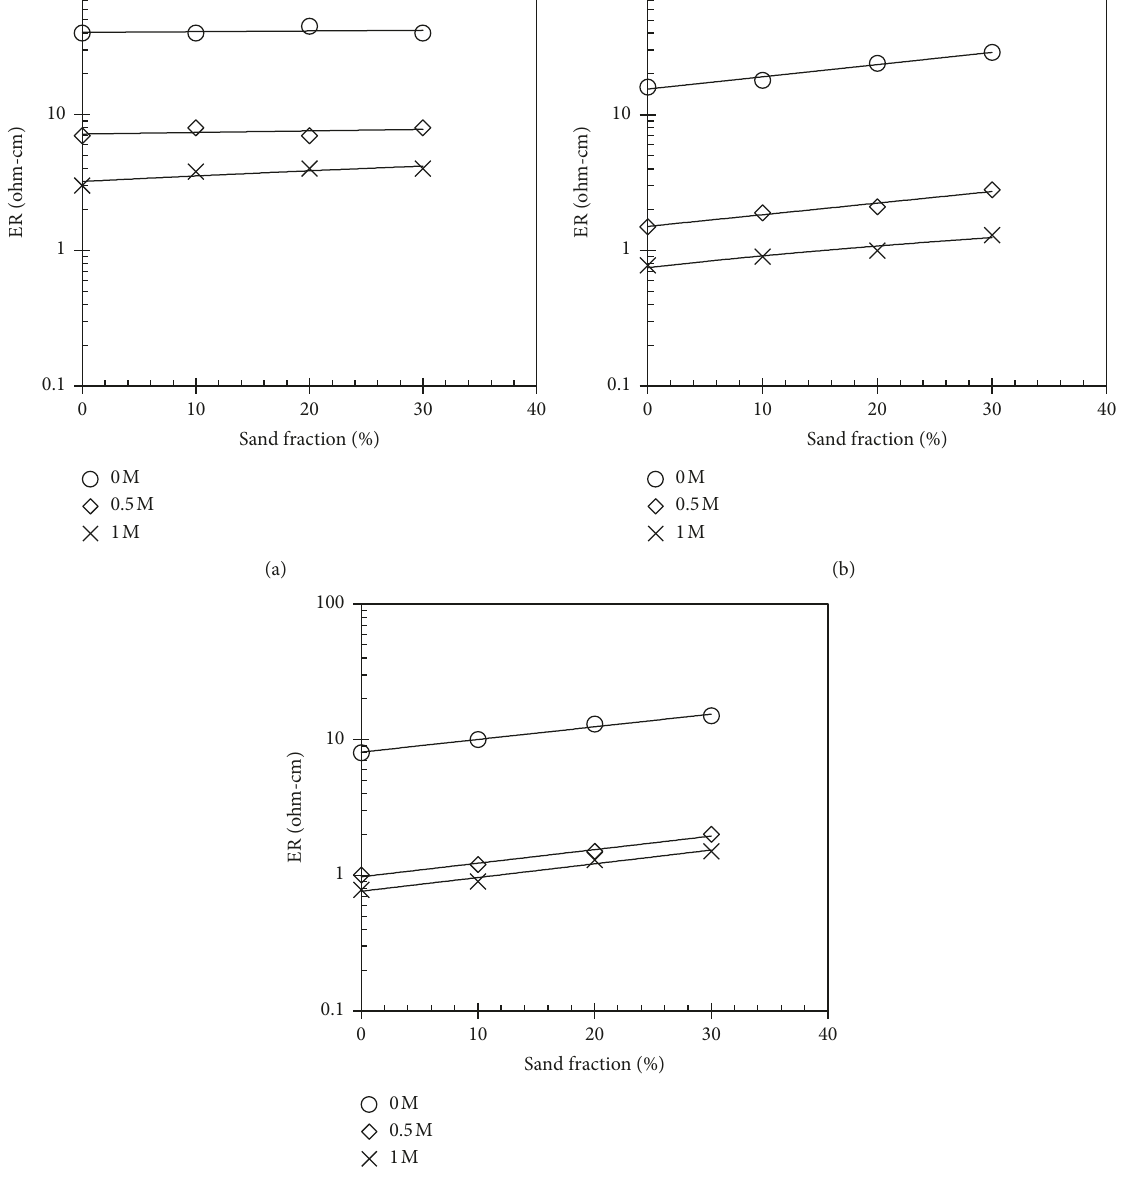
c (cid:31) 15%, (b) W c (cid:31) 20%, and (c) W c (cid:31) 25% water